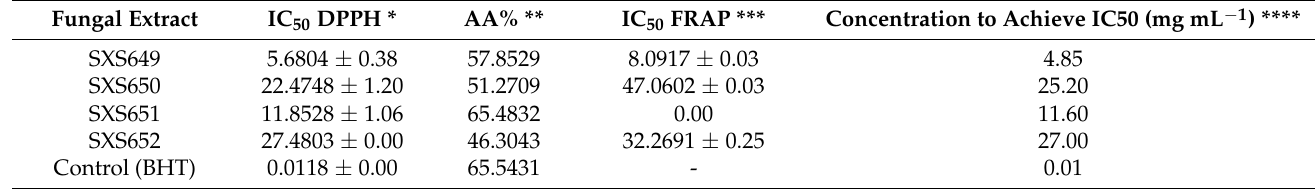
Diaporthe sp. SXS652 showed antioxidant activity at moderate levels with the DPPH and FRAP; Colletotrichum sp. SXS649 showed lower levels of antioxidant activity with the DPPH and FRAP methods; and Botryosphaeriales SXS651 showed lower levels of antioxidant activity with the DPPH method. Table 3. IC50 values (mg mL − 1 ) of the extracts of the endophytic fungi Colletotrichum sp. SXS649, Pestalotiopsis sp. SXS650, Botryosphaeriales SXS651, and Diaporthe sp. SXS652 isolates from P. rigida Kunth that inhibit DPPH free radicals and reduce iron